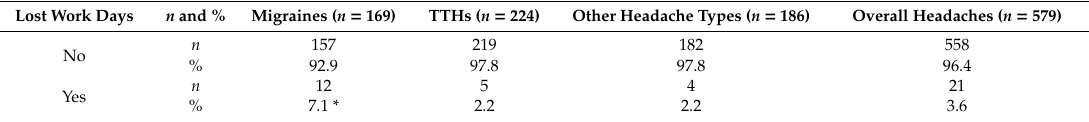
Table 1. Number ( n ) and percentage (%) of su ff erers who lost work days due to a headache in the past month. TTHs, tension-type headaches.